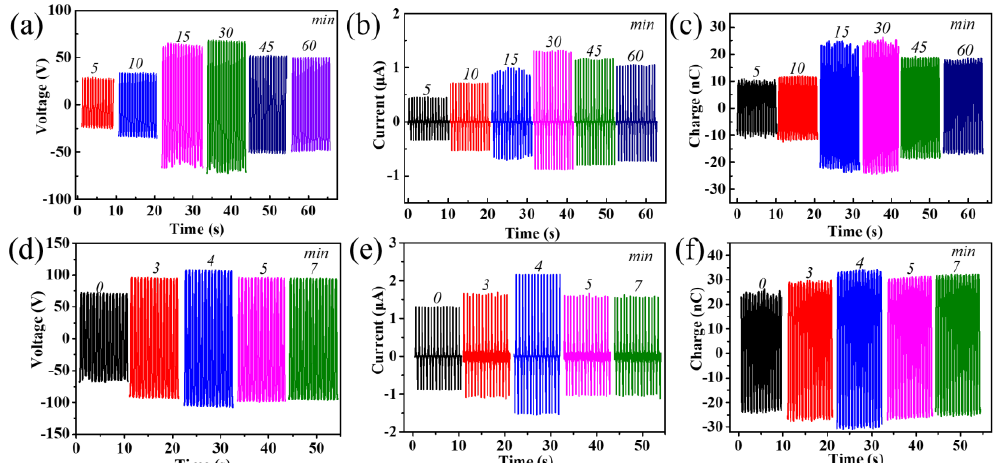
Figure 5. Electrical output of ( a ) V oc , ( b ) I sc , and ( c ) Q sc of the flexible HO-TENG based on FMs pre- pared at different electrospinning receiving times. Electrical output of ( d ) V oc , ( e ) I sc , and ( f ) Q sc of the flexible HO-TENG based on FSHMs prepared at different electrostatic spray receiving times.